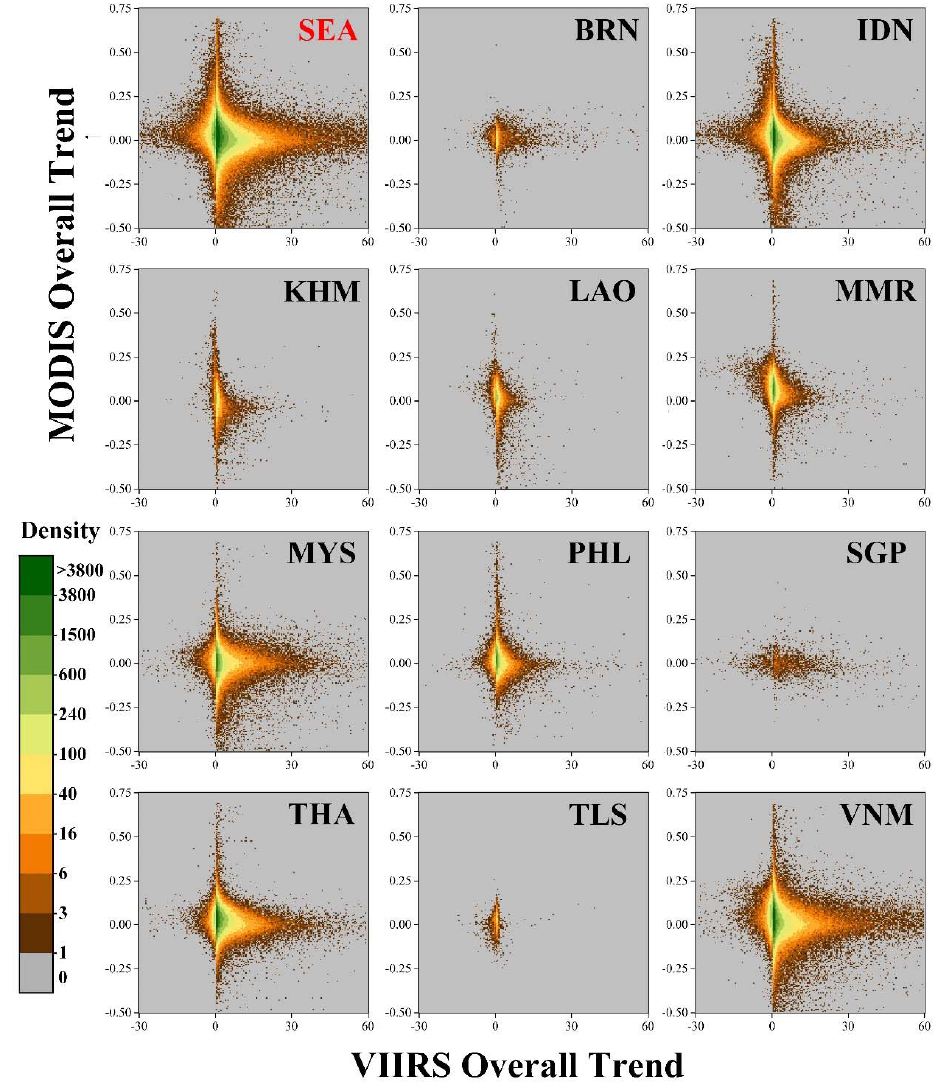
Figure 8. The heat map shows the correlation between VIIRS/DNB overall trend and MODIS/NDVI overall trend for the Southeast Asia region (SEA, total grids count: ≈ 1.85×10 6 ) and 11 countries. The color map shows the different levels of grid density. overall trend for the Southeast Asia region (SEA, total grids count: ≈ 1.85 × 10 The color map shows the different levels of grid